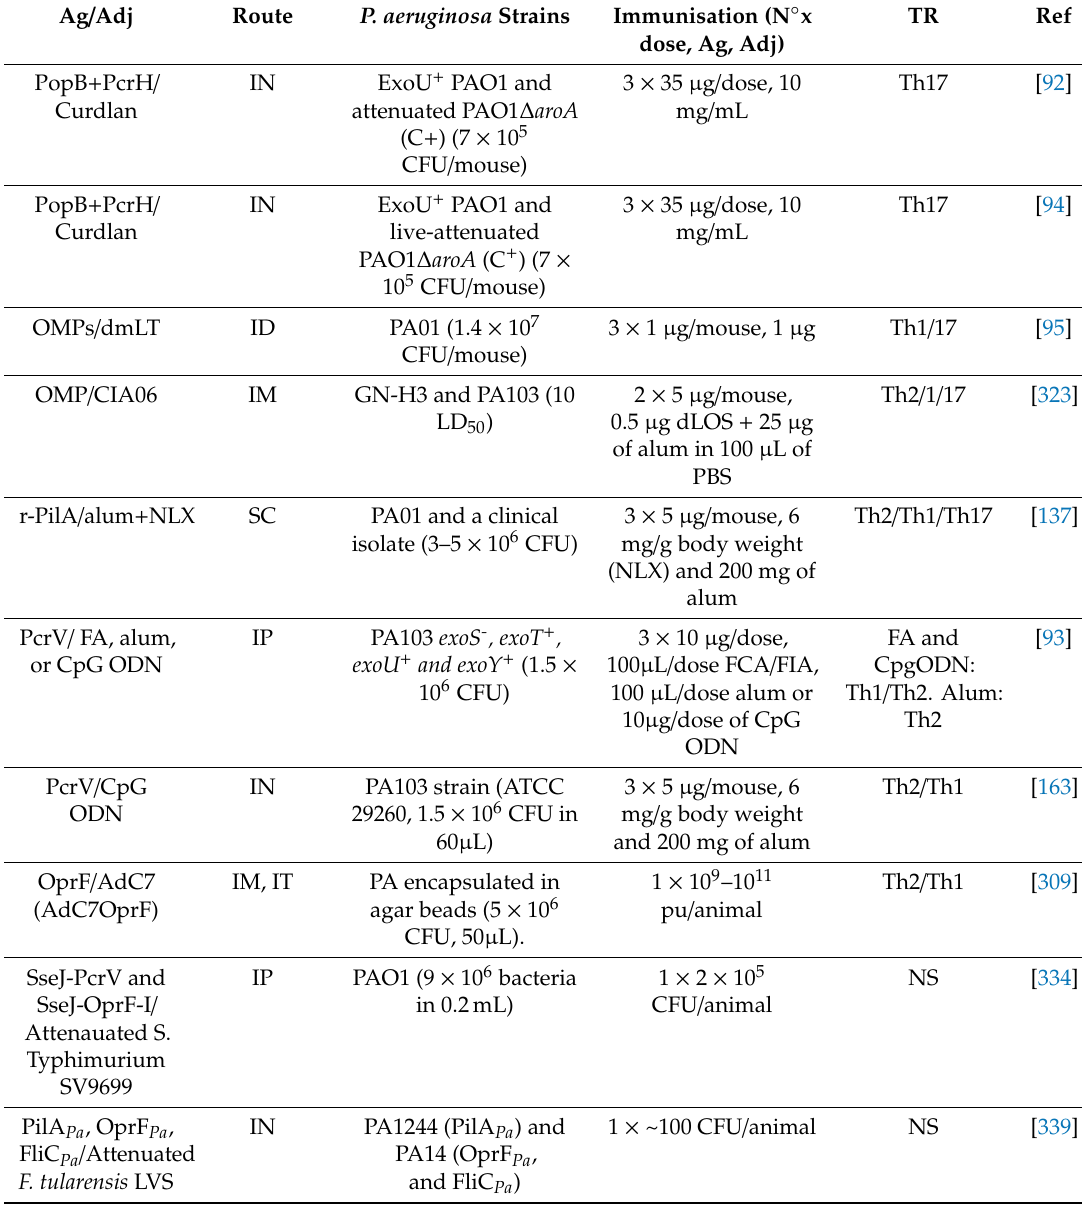
Table 3. Examples of P. aeruginosa adjuvanted vaccine evaluated in pre-clinical studies. Ag /